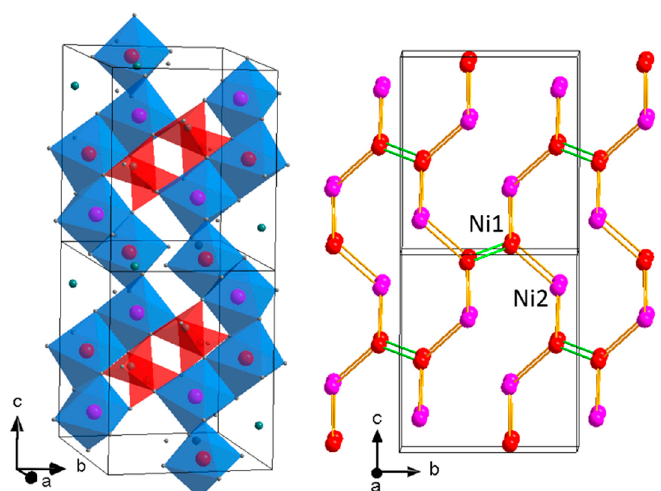
Figure 1. ( Left ) Crystallographic structure of Ni 2 V 2 O 7 (red, Ni1; pink, Ni2; green, V; gray, O). The different Ni ‒ O octahedra (blue) are isolated by V ‒ O tetrahedrons (red). ( Right ) The bonds with different colors present three possible interactions.